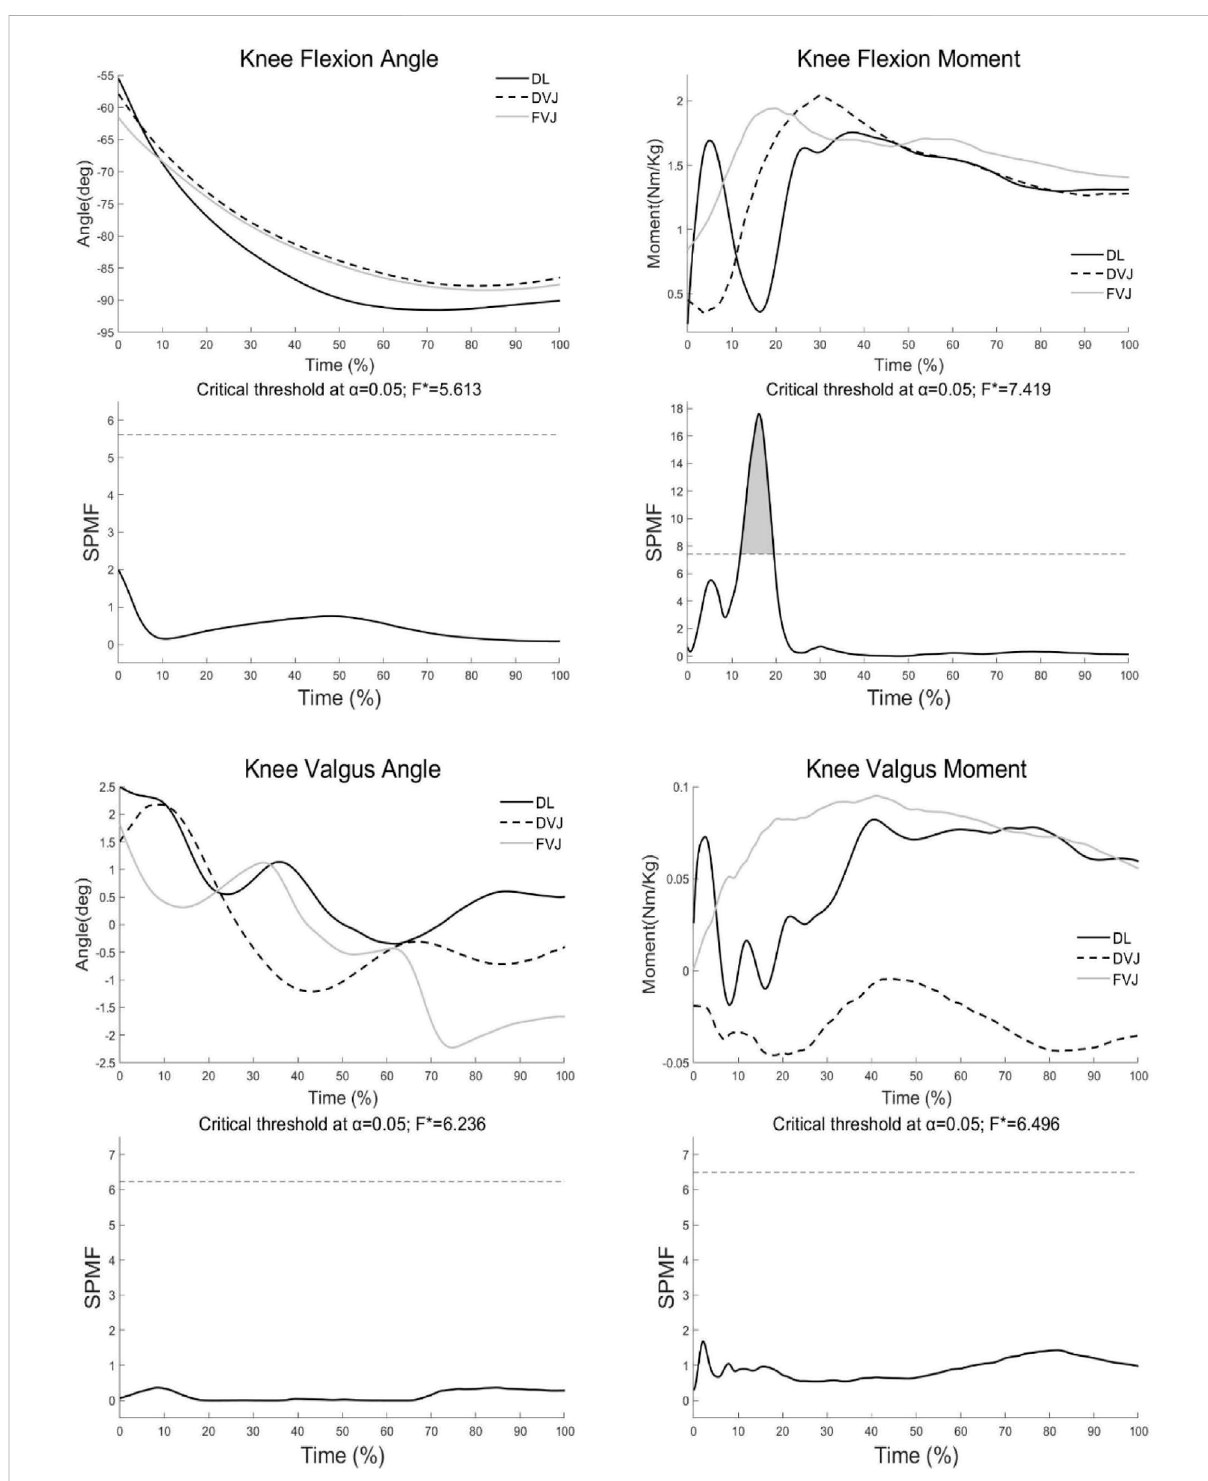
FIGURE 6 Ensemble average and SPM{F} evaluation of right knee variables against percentage time obtained from 11 subjects participating in the three landing